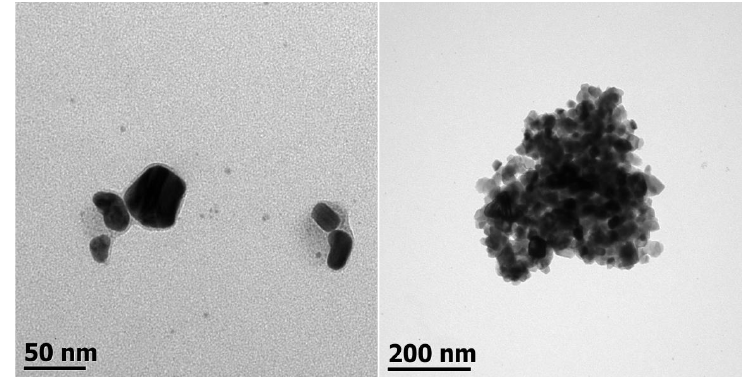
Figure 2. Electronic Transmission Microscope (TEM) images of silver nanoparticles (TEM JEOL JEM-1010 60–80 kV, Digital Micrograph 3.1 digital camera GatanBioscan 1k × 1k). Author´s own images.